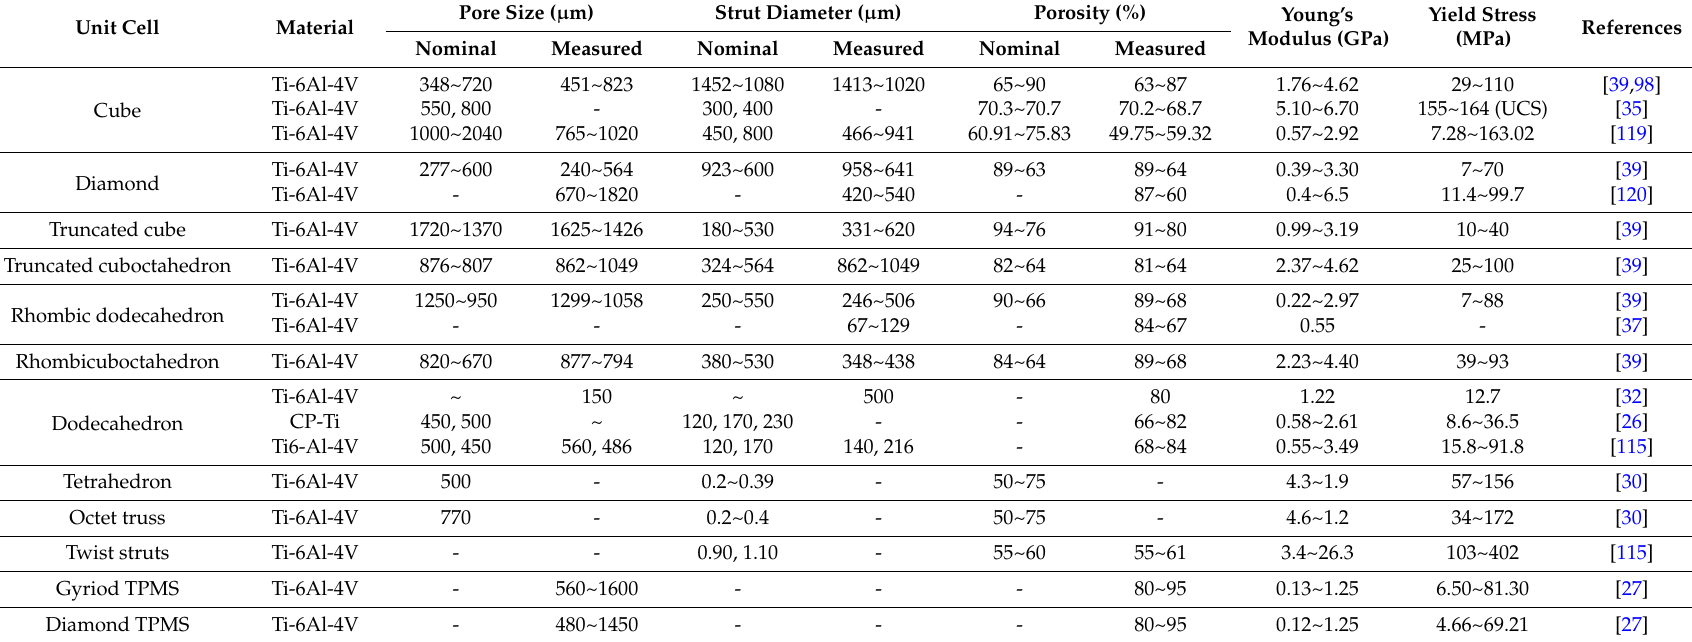
Table 3. Mechanical properties of scaffolds made of different types of unit